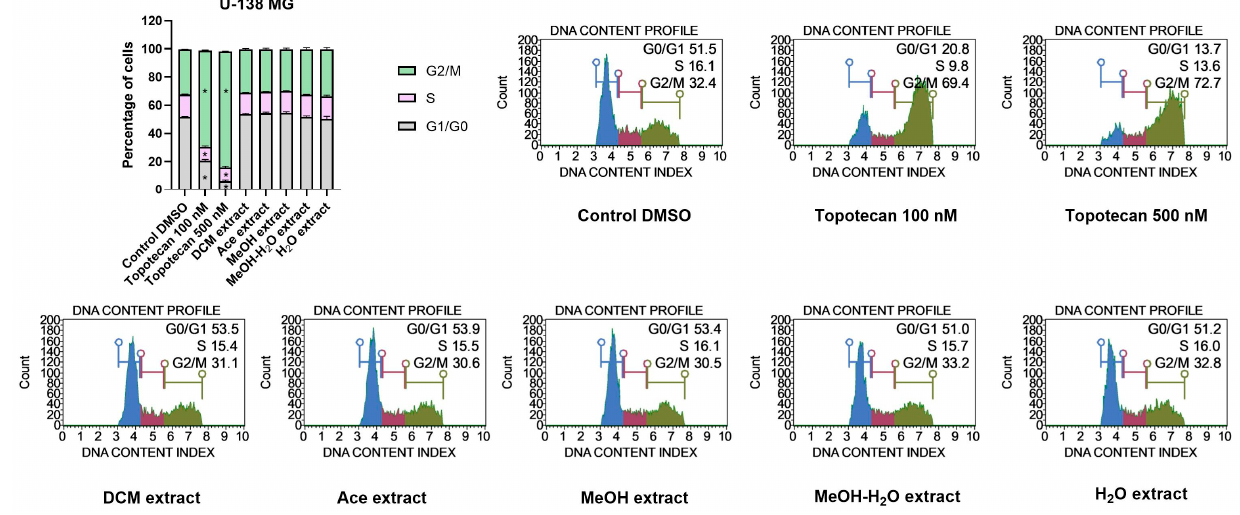
Figure 10. Cell cycle analysis of U-138 MG cells using the Muse™ Cell Cycle Kit after 48 h of treatment. The percentage of cells in G0/G1, S, and G2/M phases of the cell cycle are presented in the bar chart. The values are shown as the mean ± SEM calculated from two independent experiments. (*) indicates statistically significant differences from the control group for a particular phase, p < 0.05. Representative histograms of the controls (DMSO—negative control, topotecan—positive control) and analysed P. glauca extracts are also